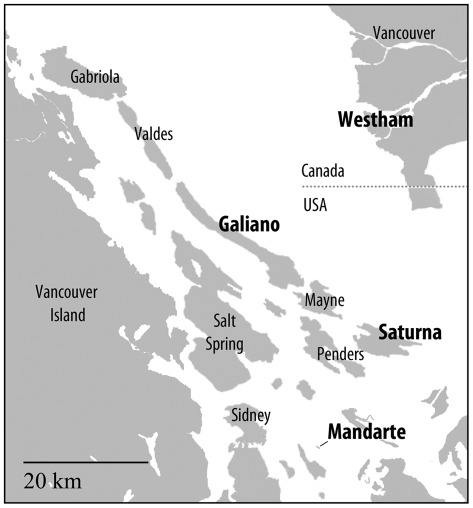
Map of the study area.
Malacosoma californicum pluviale egg masses were collected from Galiano, Mandarte, Saturna, and Westham Island (bold font) along the west coast of British Columbia.